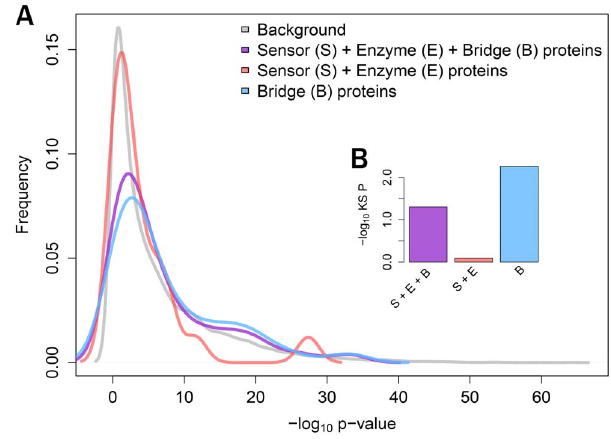
Figure 2. p-value distributions of components of a bridge network for bile acid metabolism. ( A ) p-value distributions of (i) sensor, enzyme and bridge proteins (S + E + B), (ii) sensor and enzyme proteins (S + E) and (iii) bridge proteins (B). ( B ) Comparisons of those p- value distributions with background p-value distribution. The statistical significance levels of shifted p-value distributions were determined by one-sided Kolmogorov Smirnov tests.